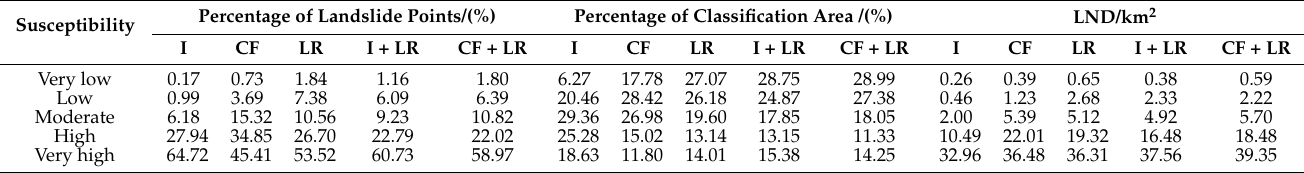
Table 4. Statistics of Minxian landslide